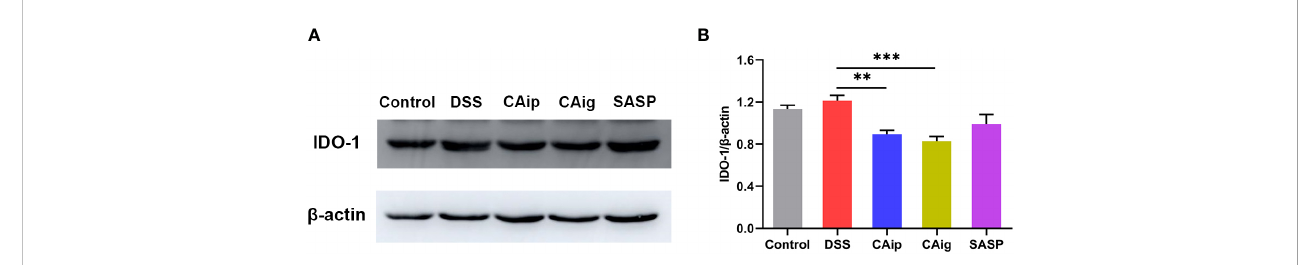
FIGURE 7 Effect of CA on the protein expression of IDO-1 in colon tissue. Representative western blotting image (A) , and the relative protein expression was normalized to b -actin (B) . Data are shown as the mean ± SEM (n = 5). ** P < 0.01, *** P < 0.001 vs. DSS